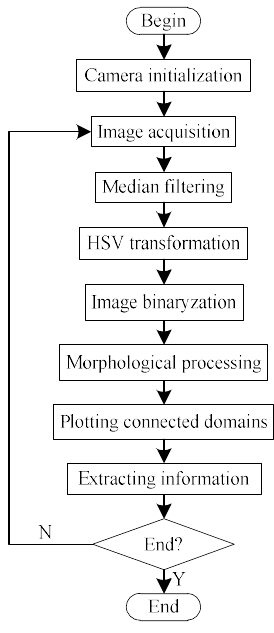
Figure 15. Process for judging ripeness of fruit.